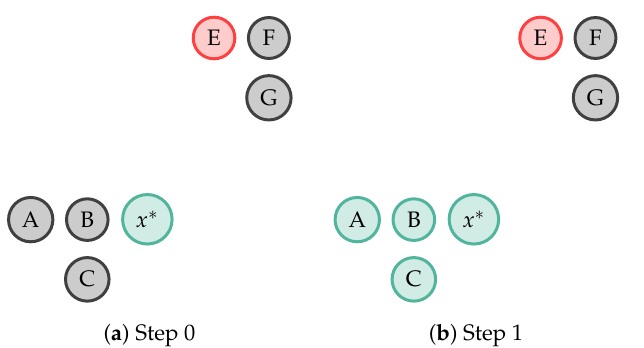
Figure 5. Example of 1-reverse Nearest Neighbour (rNN) label propagation, in which the sample x ∗ propagates its label (in this example represented by the colour green) to the samples to which, regarding the labelled samples, it is their NN, the samples A , B and C . Each circle represents a sample whose colours (green and red) represent two different classes. Samples in grey denote unlabelled